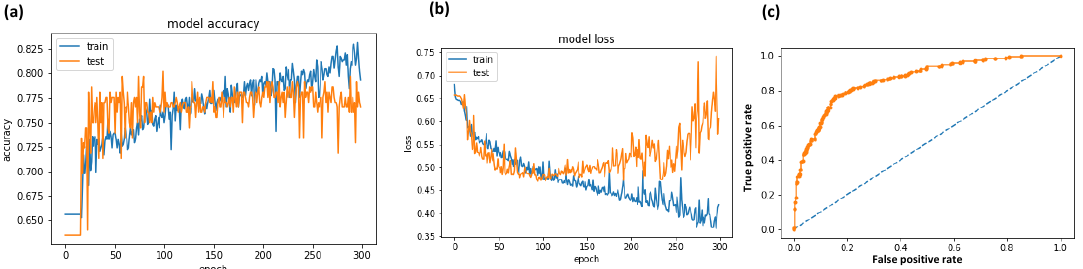
Figure 11. LSTM results (training dataset = 75%, testing dataset = 25%): ( a ) Model accuracy versus epochs; ( b ) model loss versus epochs; ( c ) ROC curve.